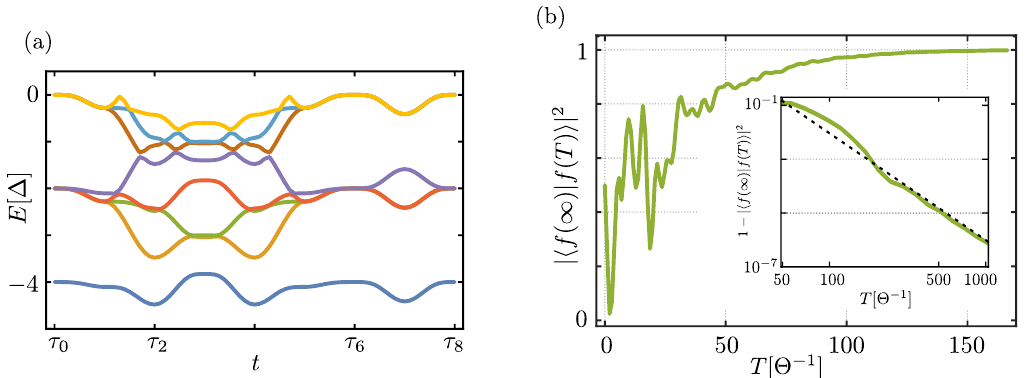
( t ) along the closed loop whose key Figure 6: (a) Spectrum of the Hamiltonian H dt As configurations are listed in Tab. 2. Only negative energies are shown. Each line is 4-fold degenerate. Energies are in units of Θ . (b) Overlap |〈 f ( ∞ ) | f ( T ) 〉| 2 as a function of the total duration of the protocol T (in units of Θ − 1 ). The inset display 1 − |〈 f ( ∞ ) | f ( T ) 〉| 2 on a logarithmic scale. The reference black dashed line displays the power law T − 4 . For both panels, we considered the eight key configurations to − τ = T / 8 and the parameters E = Θ = Θ , be equally spaced in time, i.e. τ j + 1 j x Θ = 1.2 Θ and Θ = 0.8 Θ y 1 y 2